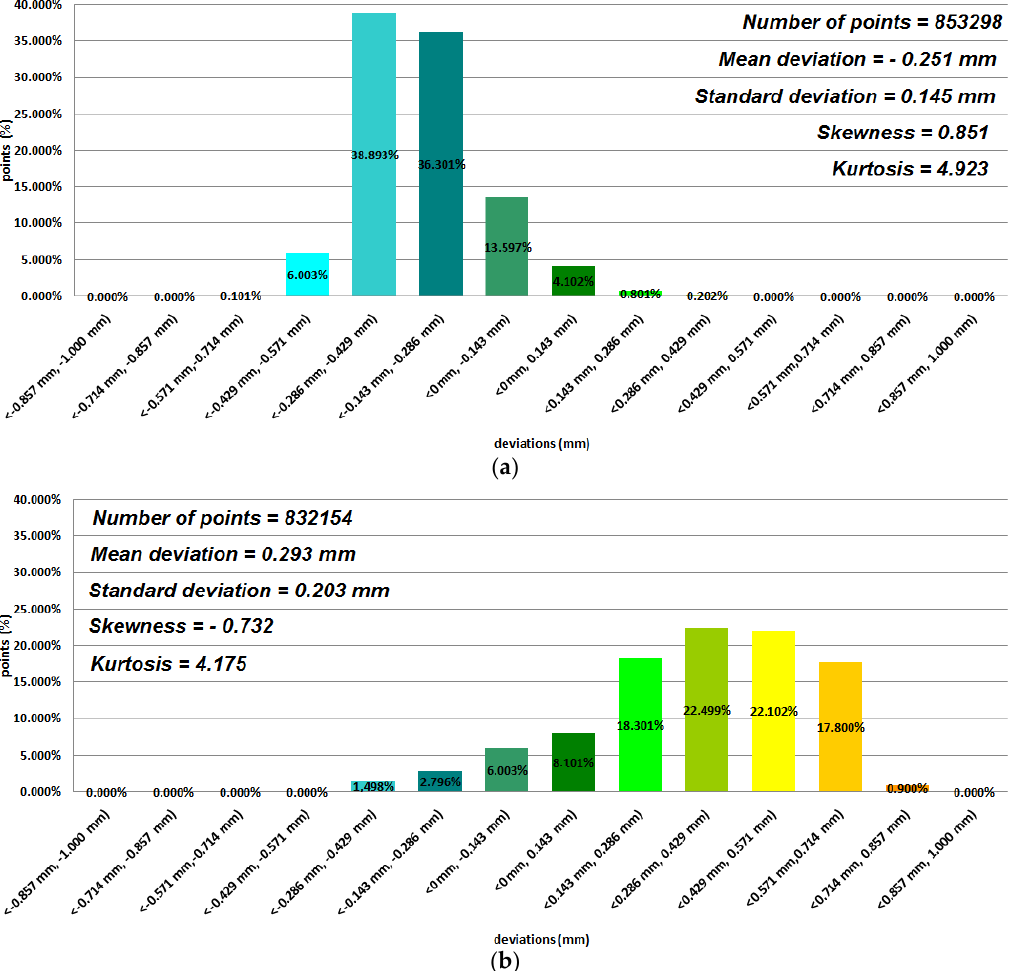
( c ) Figure 6. Histograms representing average results of the 12 mandible structures: ( a ) E-Model material; ( b ) Precimid 1170 material; ( c ) FullCure 830 material.